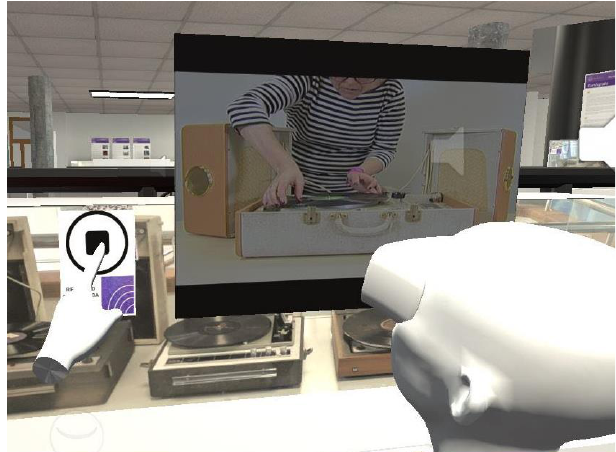
Figure 5. 1954 Thorens portable turntable multimedia content executed in the VR application.